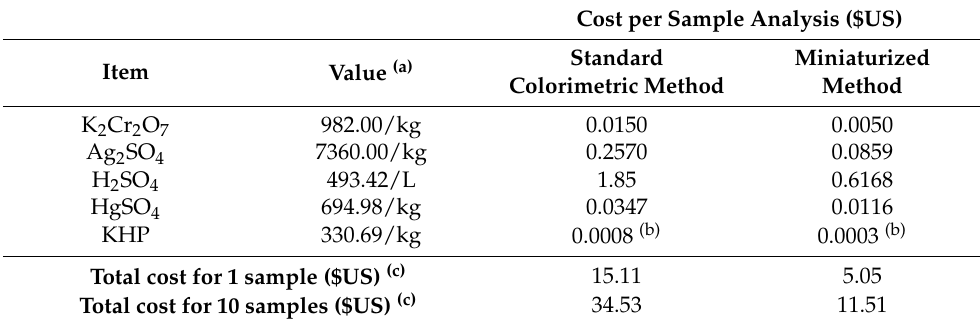
Table 3. Costs of consumables used for COD analysis: cost per item per sample, total cost per sample, and total cost for the analysis of 10 samples.